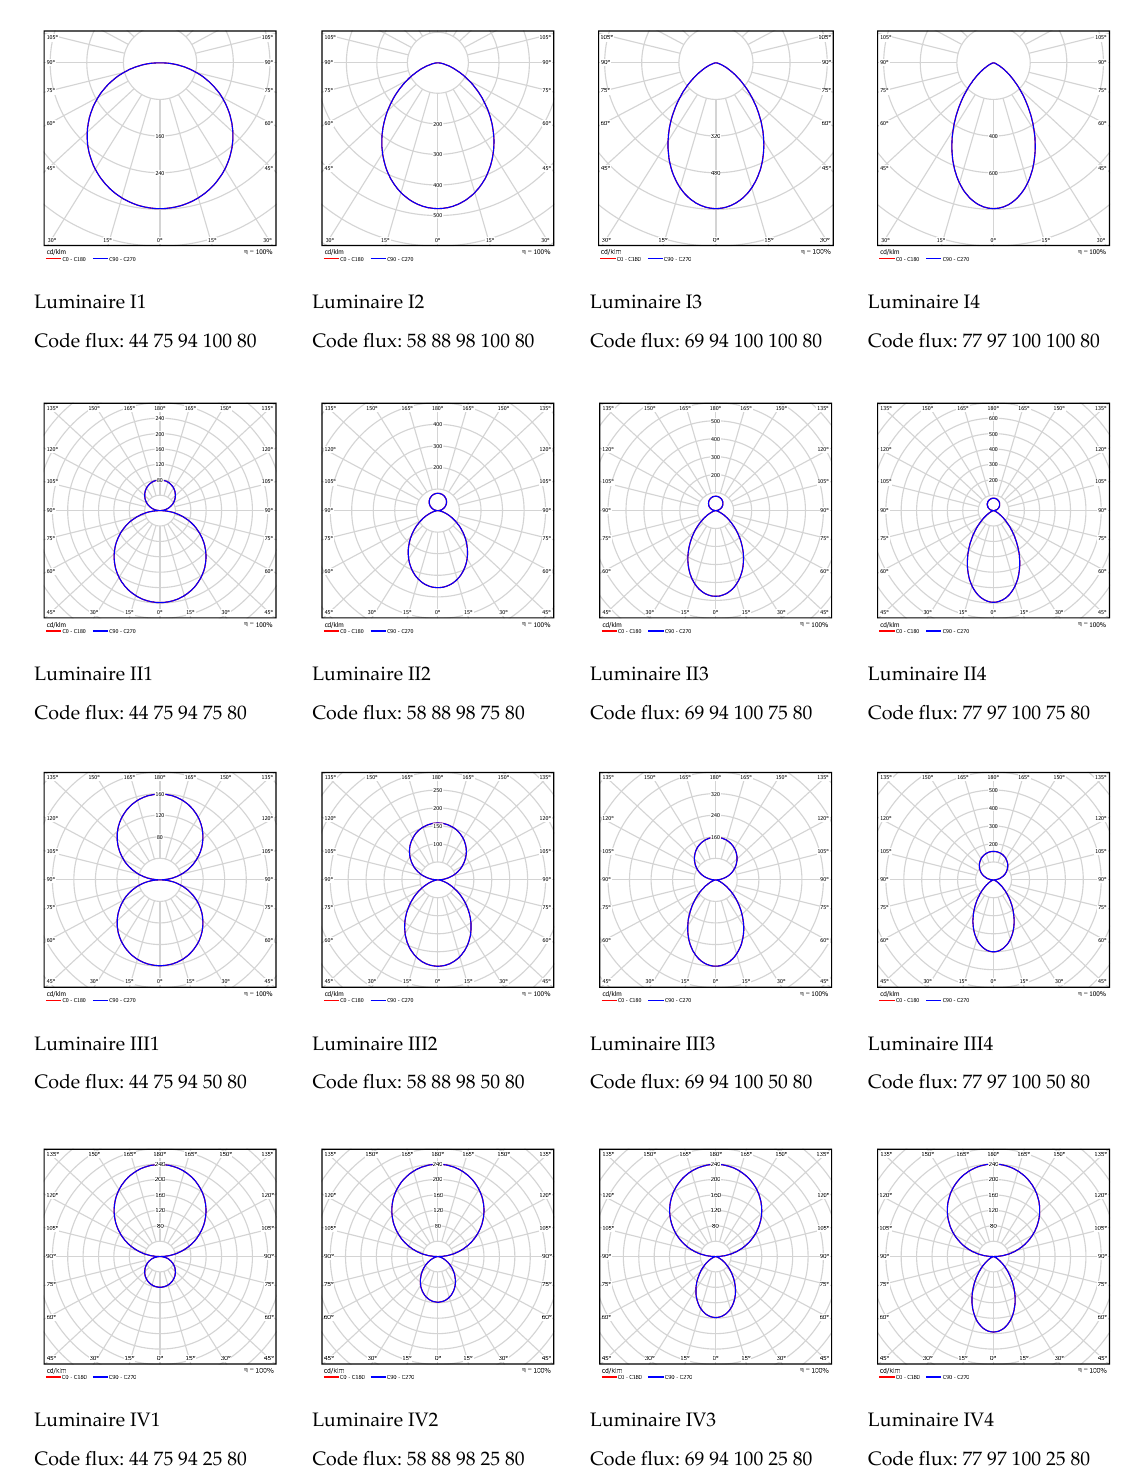
Figure 1. Characteristics of the luminaires for the study.